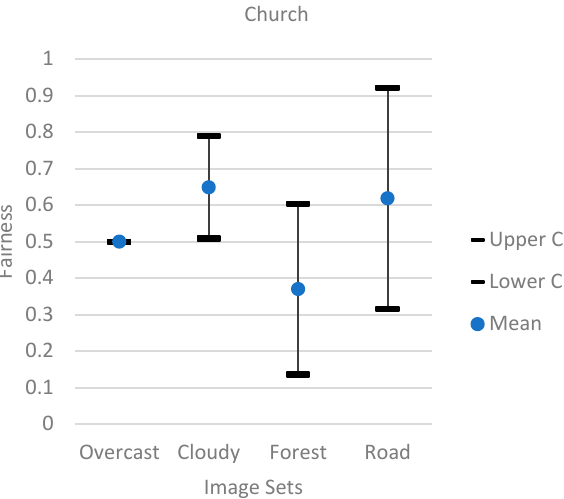
Figure 7. The 95% con fi dence interval graph for the mountain model.